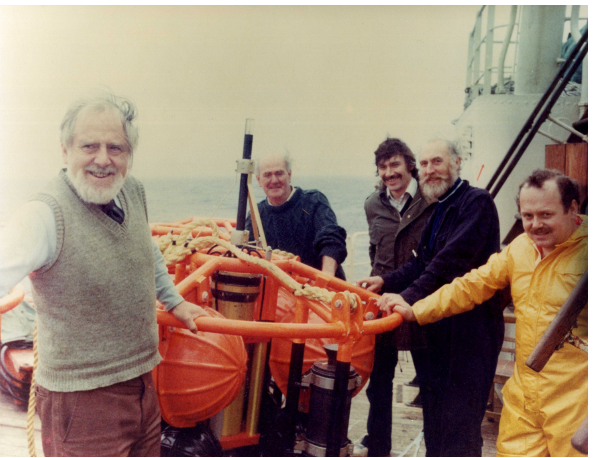
Figure 3. David Cartwright, FRS (1926–2015) (left) and colleagues around a “Mark IV” bottom pressure recorder deployed to measure the tide in over 3000m of water NE of the Azores in 1980. Others appearing in the photograph (left to right): Ken Parry, Ian Vassie, Bev Hughes and Bob Spencer. Photograph courtesy of the National Oceanography